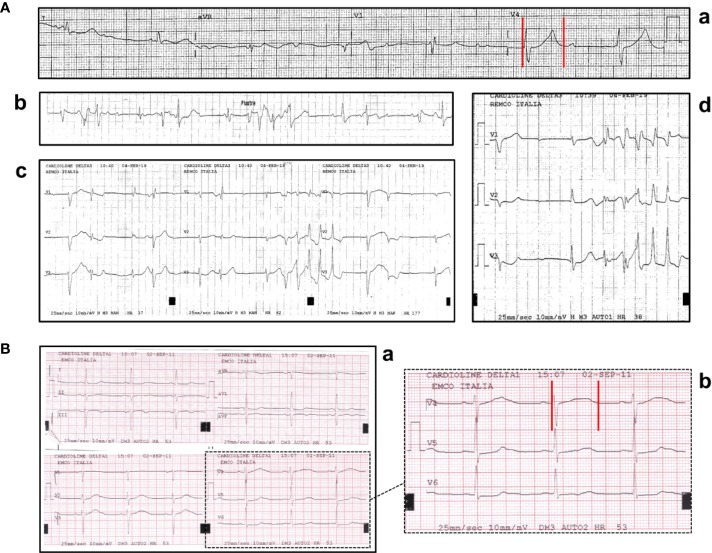
(A) ECG findings in patient 1: (a) QTc prolongation (530 ms); (b-d) recurrent episodes of self-terminating Torsades de Pointes. (B) ECG findings in patient 2: sinus bradycardia with marked QTc prolongation (610 ms). Red vertical lines in lead V4 show the QT interval.